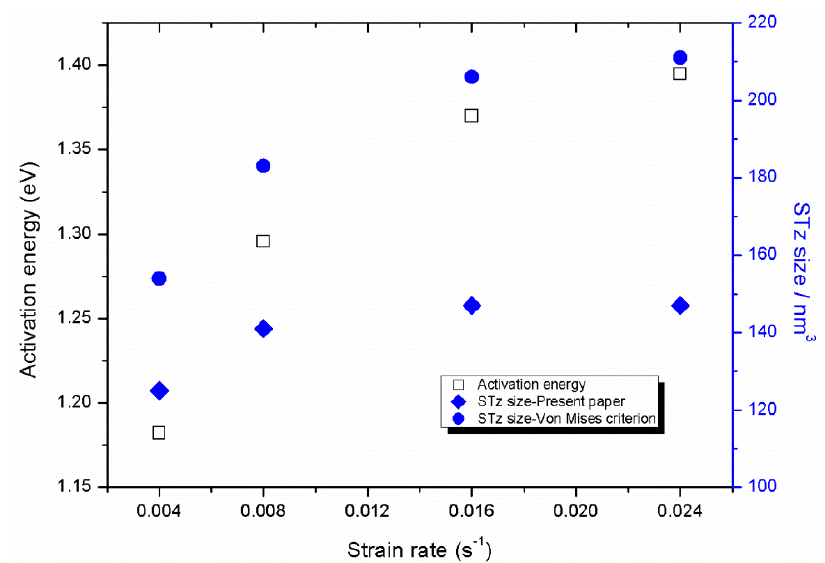
Figure 7. Shear transformation zone (STz) size calculated through different yield models and activation energy under four strain rate. Table 2. Parameters of indentation size effects under different strain rate.